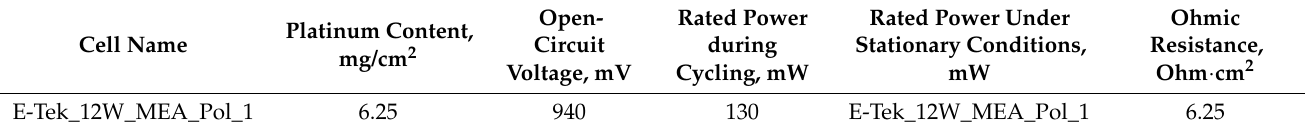
Table 3. E-Tek fuel cell